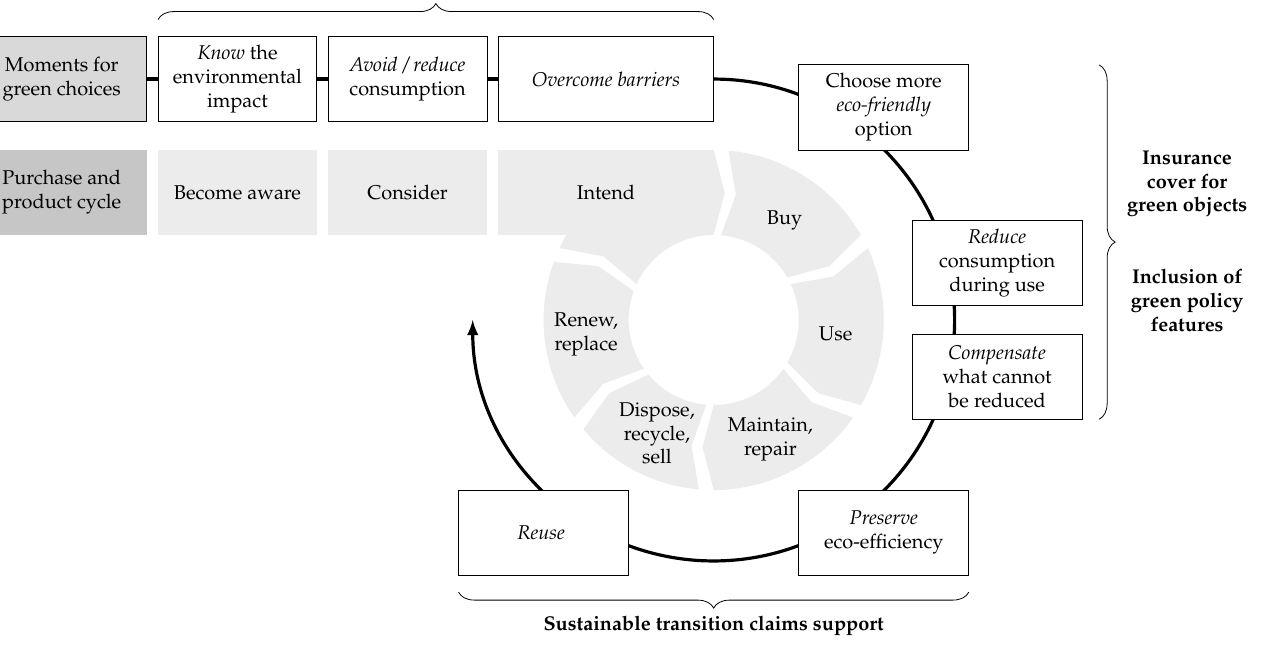
Figure 1. Types of green insurance propositions along the purchasing and product life cycles (adapted from Pugnetti et al.